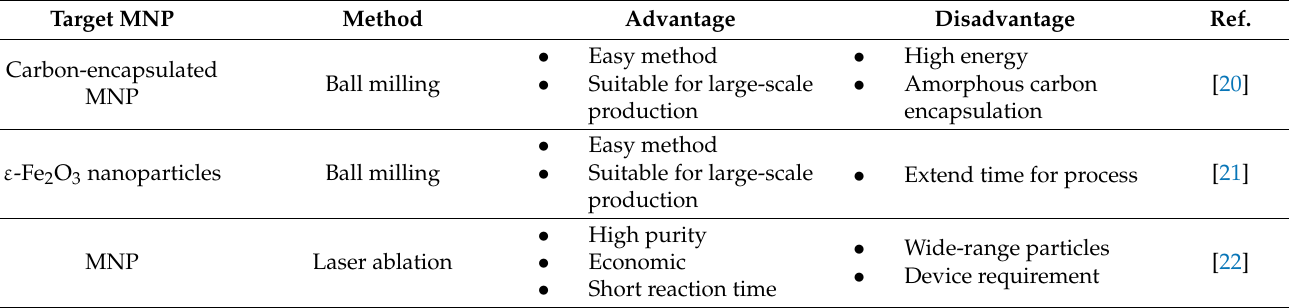
Table 1. There are some studies about the methods used for MNP